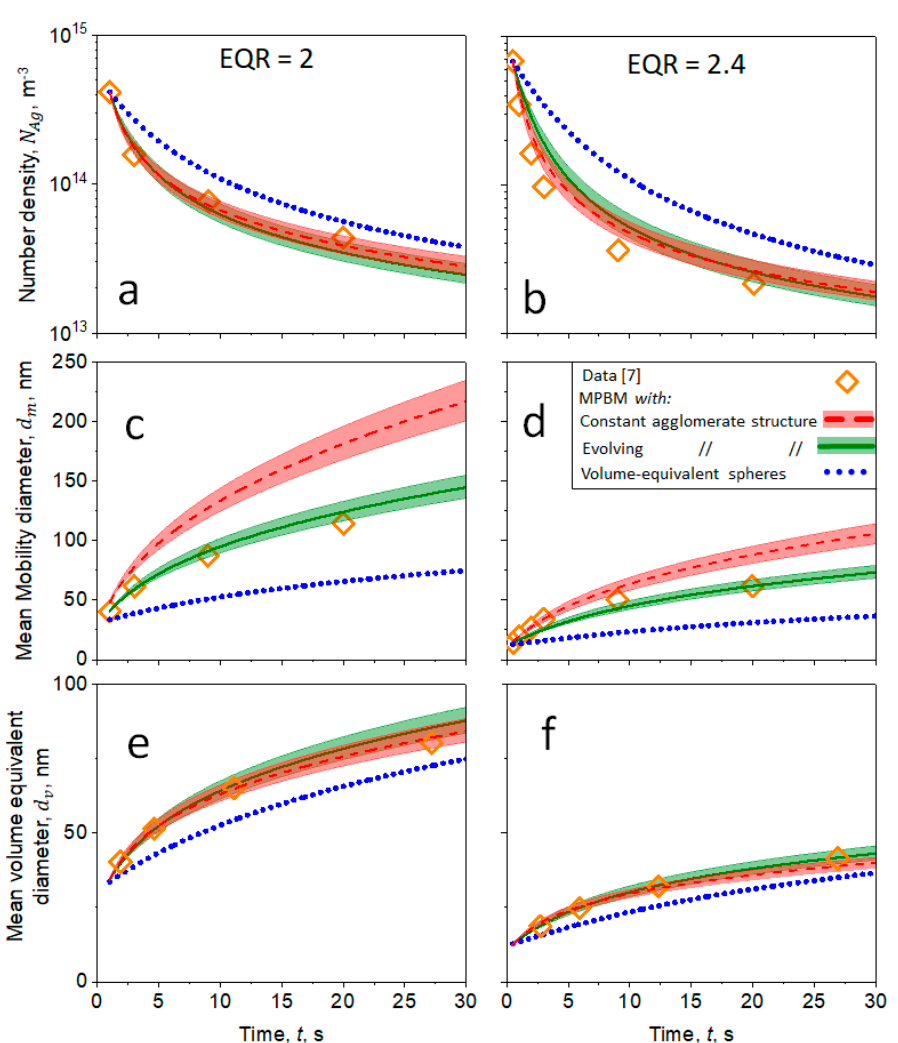
Figure 7. Evolution of agglomerate ( a , b ) N Ag , ( c , d ) d m and ( e , f ) d v as a function of t measured (diamonds) for soot sampled from premixed flames with EQR = 2 ( a , c , e ) and 2.4 ( b , d , f ) [7] compared to those derived by the MPBM (lines, shades) for volume-equivalent spheres (dotted lines) or agglomerates with constant (broken lines) and evolving morphology (solid line). All sub-figures ( a – f ) share the same